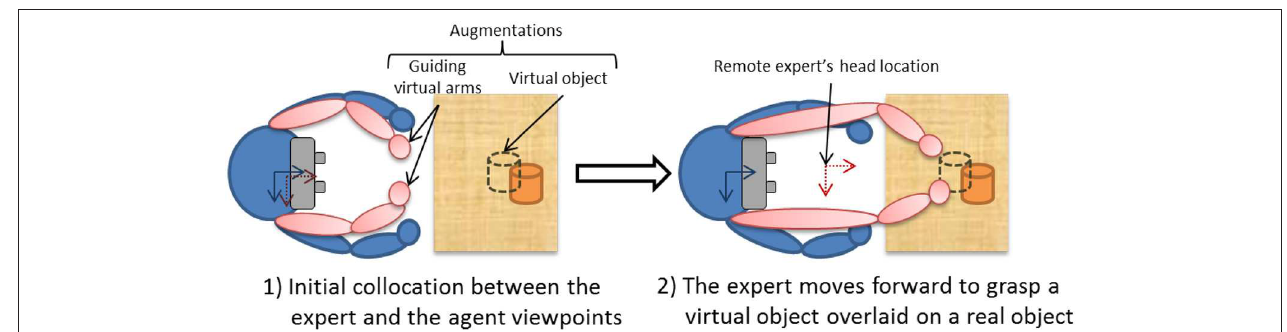
FIGURE 10 | Illustration of the principle of the stretchable guiding arms technique. The agent’s side is shown in blue. From the expert’s viewpoint (shown in red), the virtual arms do not scale and also remain collocated with his or her shoulders.